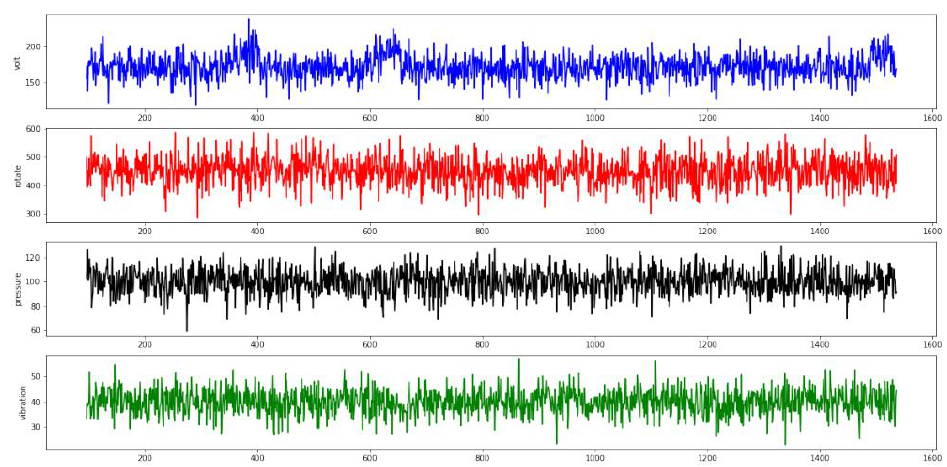
Figure 11. Telemetry data for vibration and pressure.